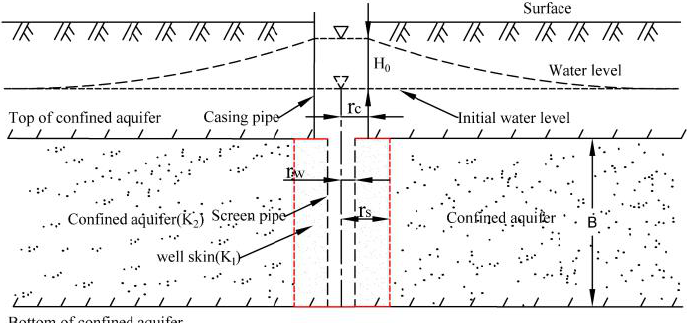
Figure 1. Schematic diagram of the slug test model considering well-skin effect (The red dashed line represents the outer wall of the well skin layer, and the red area represents the internal structure of the well skin layer).